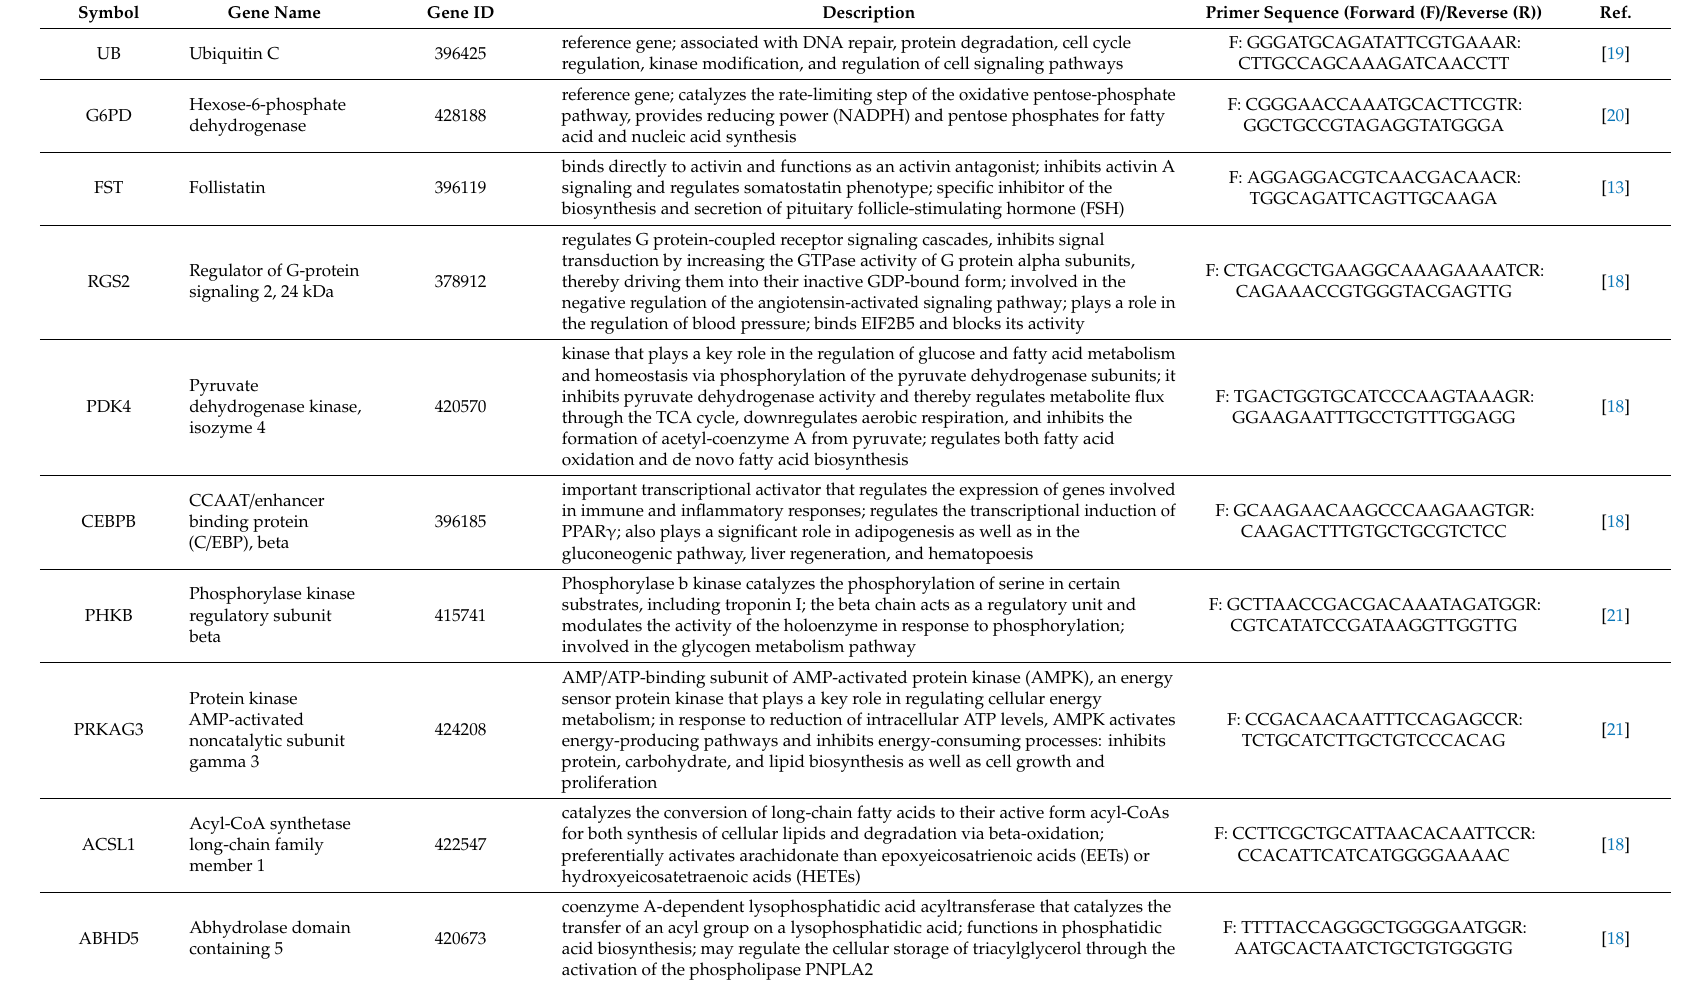
Table 1. Primer sequences used in the RT-qPCR